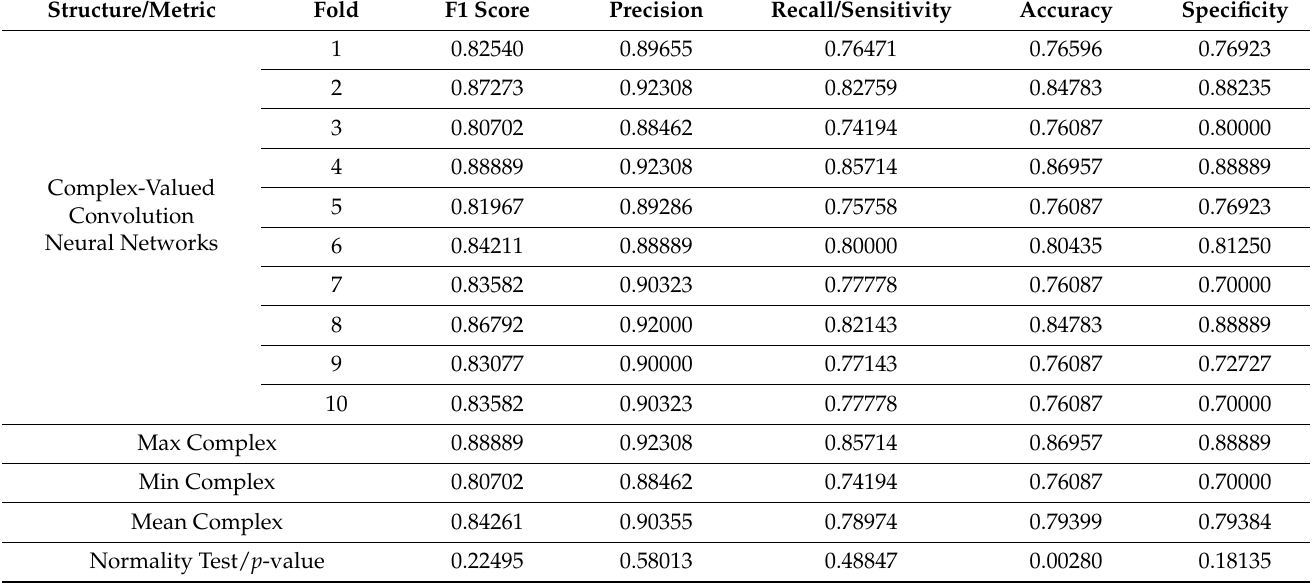
Table 12. Results obtained with the complex-valued convolution network studied for the Pascal